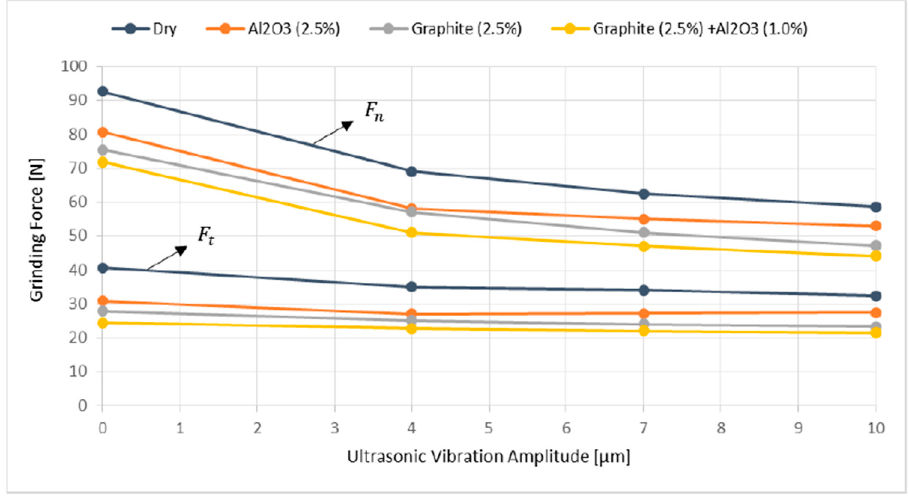
Figure 8. Effect of ultrasonic vibration amplitude on grinding forces.